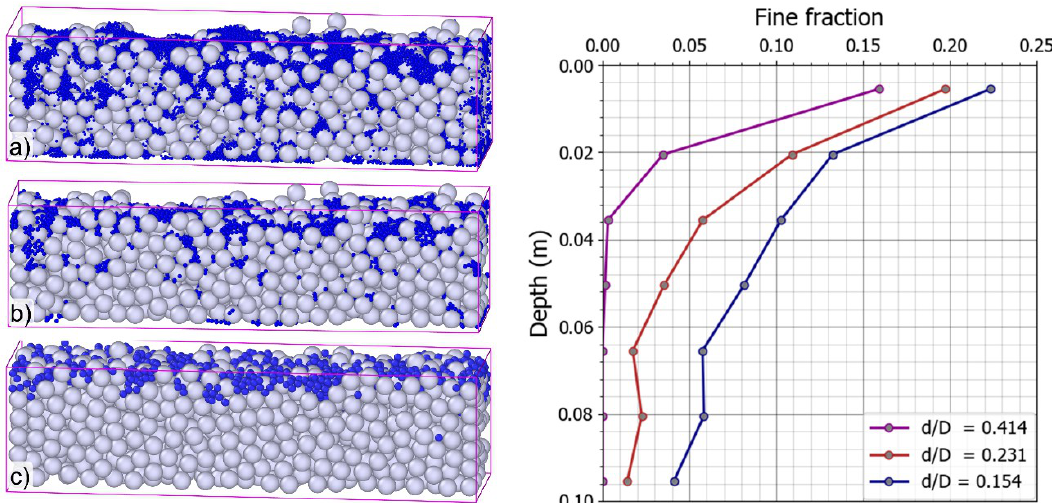
Figure 6. The structure of bed gravel and fine sediment distribution depends on the size ratio (d/D). Left : Fine sediments distribution at a cross‐section along the channel at the final computational step with d/D = 0.154 ( a ), d/D = 0.231( b ), and d/D = 0.414 ( c ); Right : Fine fraction variation in gravel depth with different size ratio.